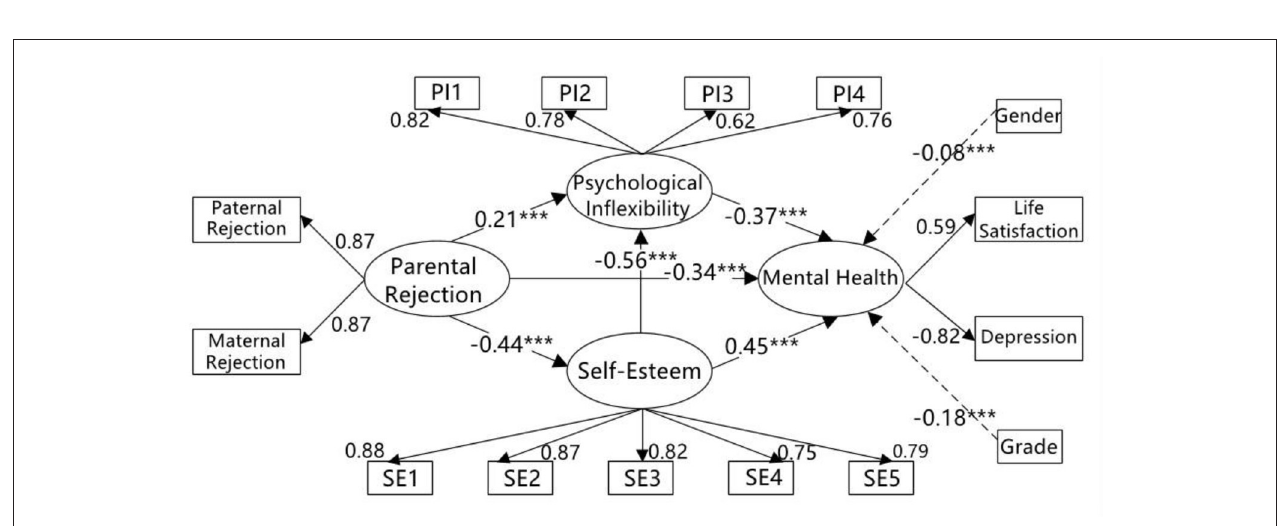
FIGURE 2 | The mediating roles of self-esteem and psychological inflexibility between parental rejection and mental health. PI1–PI4, four parcels of psychological inflexibility; SE1–SE5, five parcels of self-esteem; *** p < 0.001.